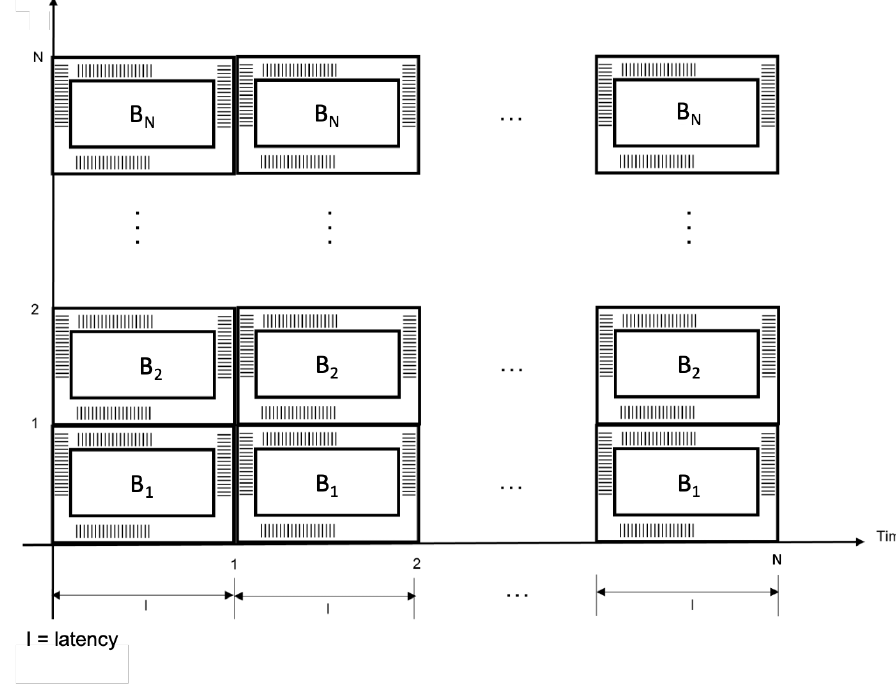
Figure 9. Hardware redundancy enables N B i blocks, for 1 ≤ i ≤ N , where N ∈ Z + , to operate in a parallel way during a given latency l